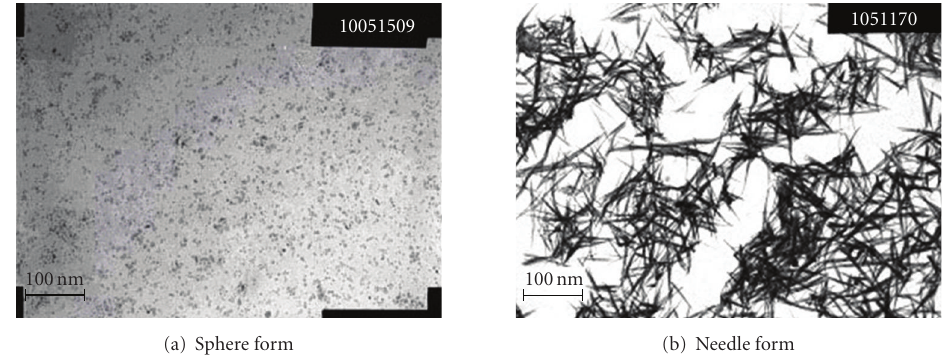
Figure 7: TEM photos of products with di ff erent forms.